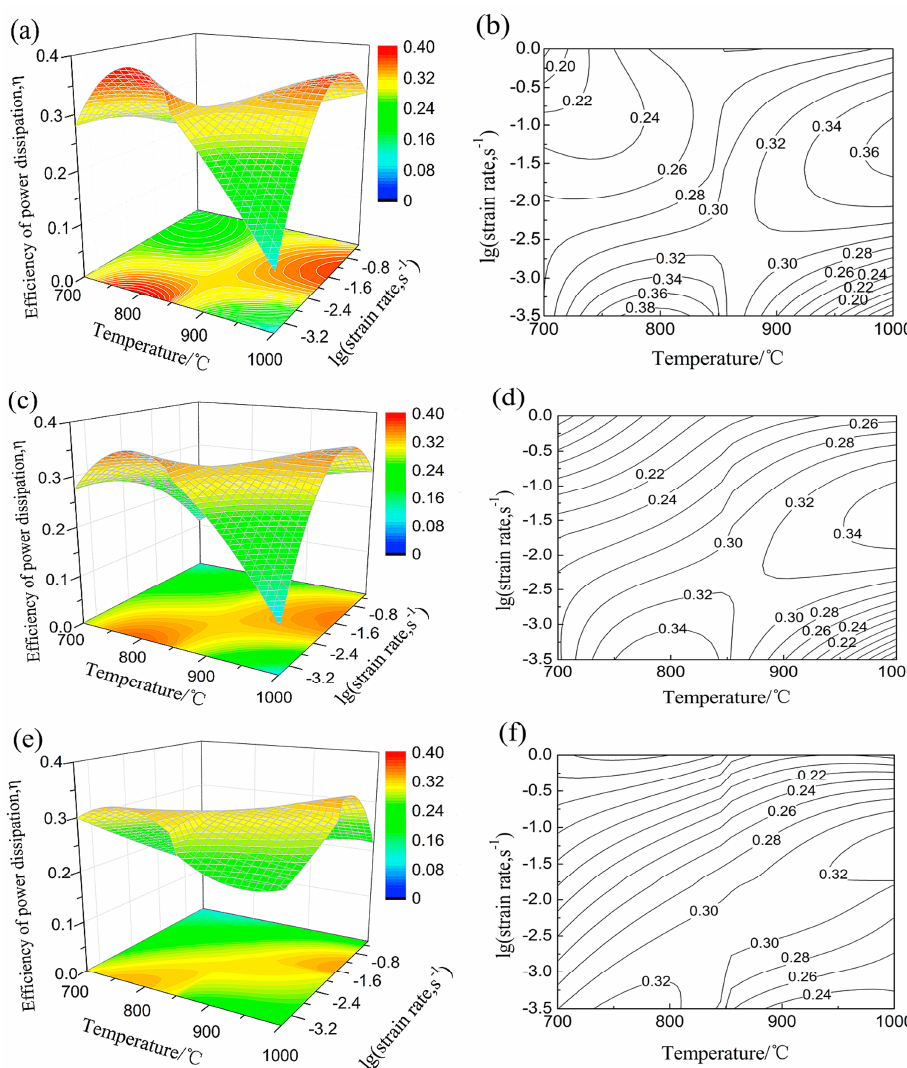
Figure 5. Power dissipation maps of NiTiNb SMA based on various strains: ( a ) ε = 0.3, 3D surface map; ( b ) ε = 0.3, 2D contour line map; ( c ) ε = 0.6, 3D surface map; ( d ) ε = 0.6, 2D contour line map; ( e ) ε = 0.9, 3D surface map; and ( f ) ε = 0.9, 2D contour line